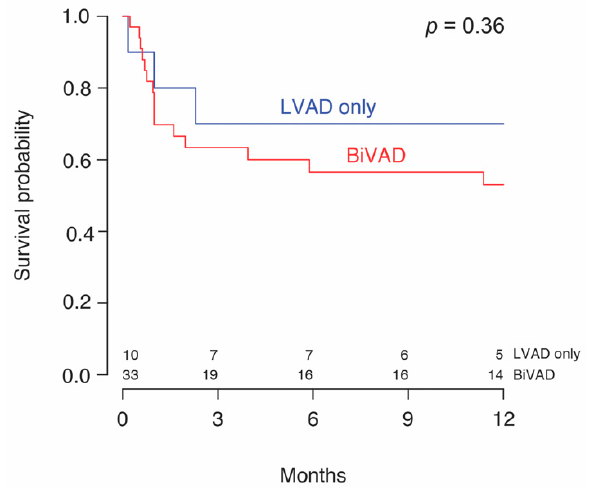
Figure 2. Survival probability of patients with giant cell myocarditis treated with immunosuppression (IS) before or after mechanical circulatory support (MCS).